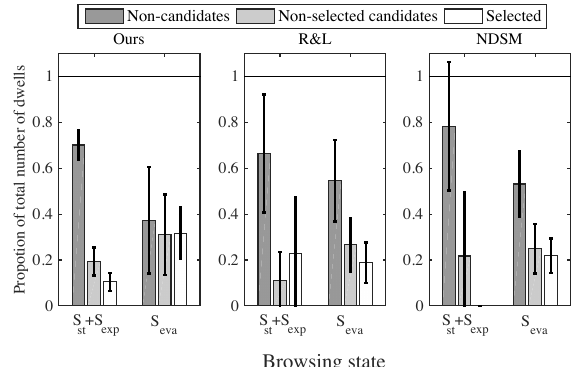
Figure 9 . The proportion of total dwells in browsing states. The whiskers represent standard deviation.